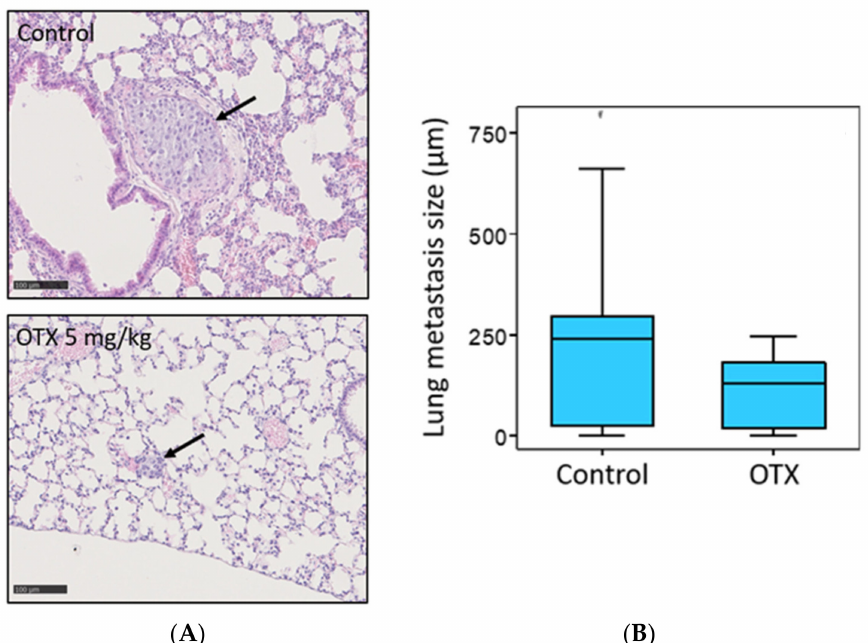
Figure 10. Evaluation of lung metastasis development from 8505c xenografts in control and OTX008- treated mice. ( A ) Lung sections colored by hematoxylin/eosine solution showing a large metastasis in a non-treated mouse and a small metastasis in a treated mouse. ( B ) Statistical comparison of lung metastasis sizes between control and OTX groups. The Mann Whitney test was conducted to evaluate